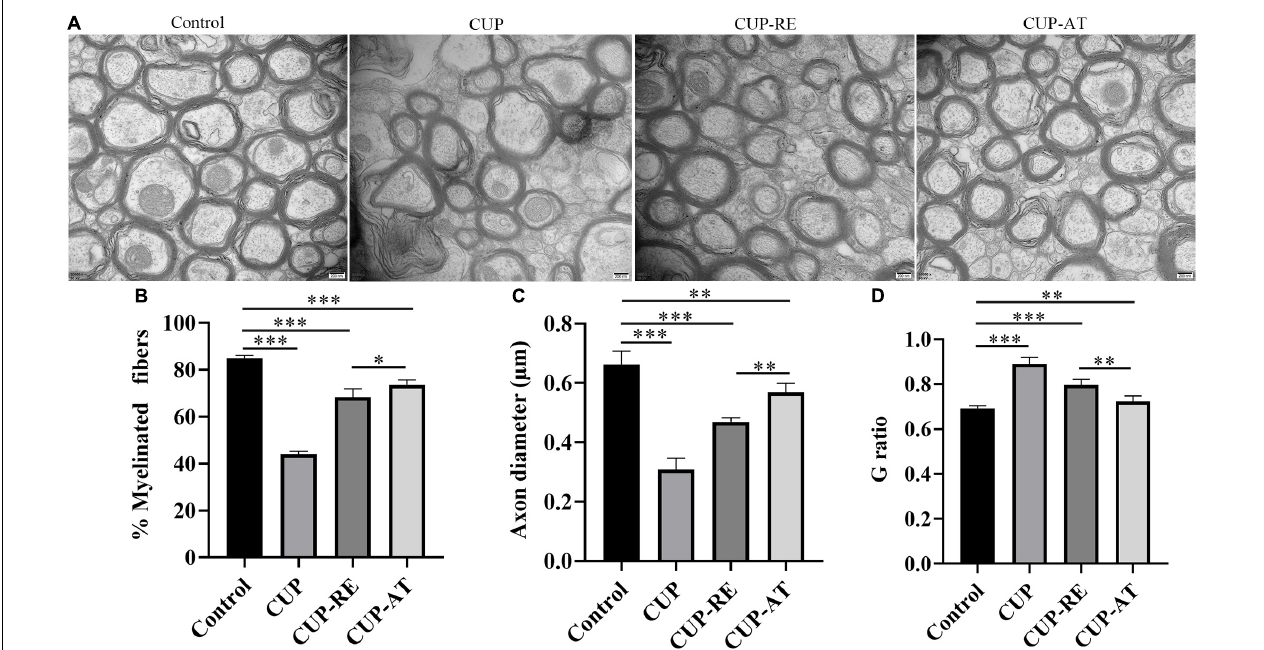
FIGURE 6 | Acer truncatum oil supplementation can be of advantage to recover the damage of axonal and myelin in the MS mouse model. (A) The TEM photomicrographs were taken from coronal sections of the corpus callosum, healthy myelin sheaths with normal and intact structures were observed of the corpus callosum in control group, whereas disintegration of neural fibers was found in CUP mice. Acer truncatum oil supplementation was efficient in the recovery of myelin sheaths from pathological morphology, in comparison to CUP-RE group mice, in which lower electron density and less well-defined myelin sheaths was found. (B) Quantitative analysis of the myelinated fibers. The percentage of the myelinated fibers in the corpus callosum of mice administrated with CUP significantly decreased compared with that in control group. Dietary Acer truncatum oil supplementation significantly increased in axon diameter as compared to that in the CUP-RE group. (C) Quantitative analysis of the axon diameter. Axon diameter in mice administrated with CUP significantly decreased compared with that in control group, Axon diameter after dietary Acer truncatum oil supplementation significantly increased as compared to that in the CUP-RE group. (D) Quantitative analysis of the G ratio. The G ratio in CUP mice was significantly increased compared with that in control group, after dietary Acer truncatum oil treatment, the G ratio was significantly reduced compared with the CUP-RE group. n = 9/group. Scale bar: 200 nm. Data were expressed as means ± SEM. Differences between groups were expressed as ∗ p < 0.05, ∗∗ p < 0.01, ∗∗∗ p <